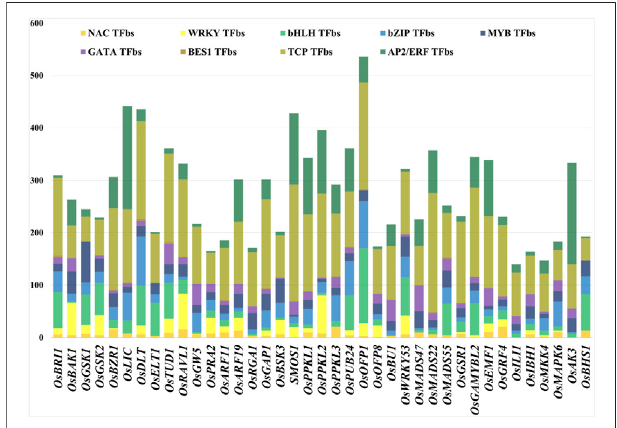
FIGURE 3 | Different numbers of TFbs in each 1.5-kb upstream promoter sequence. Different colors represent different TFbs.